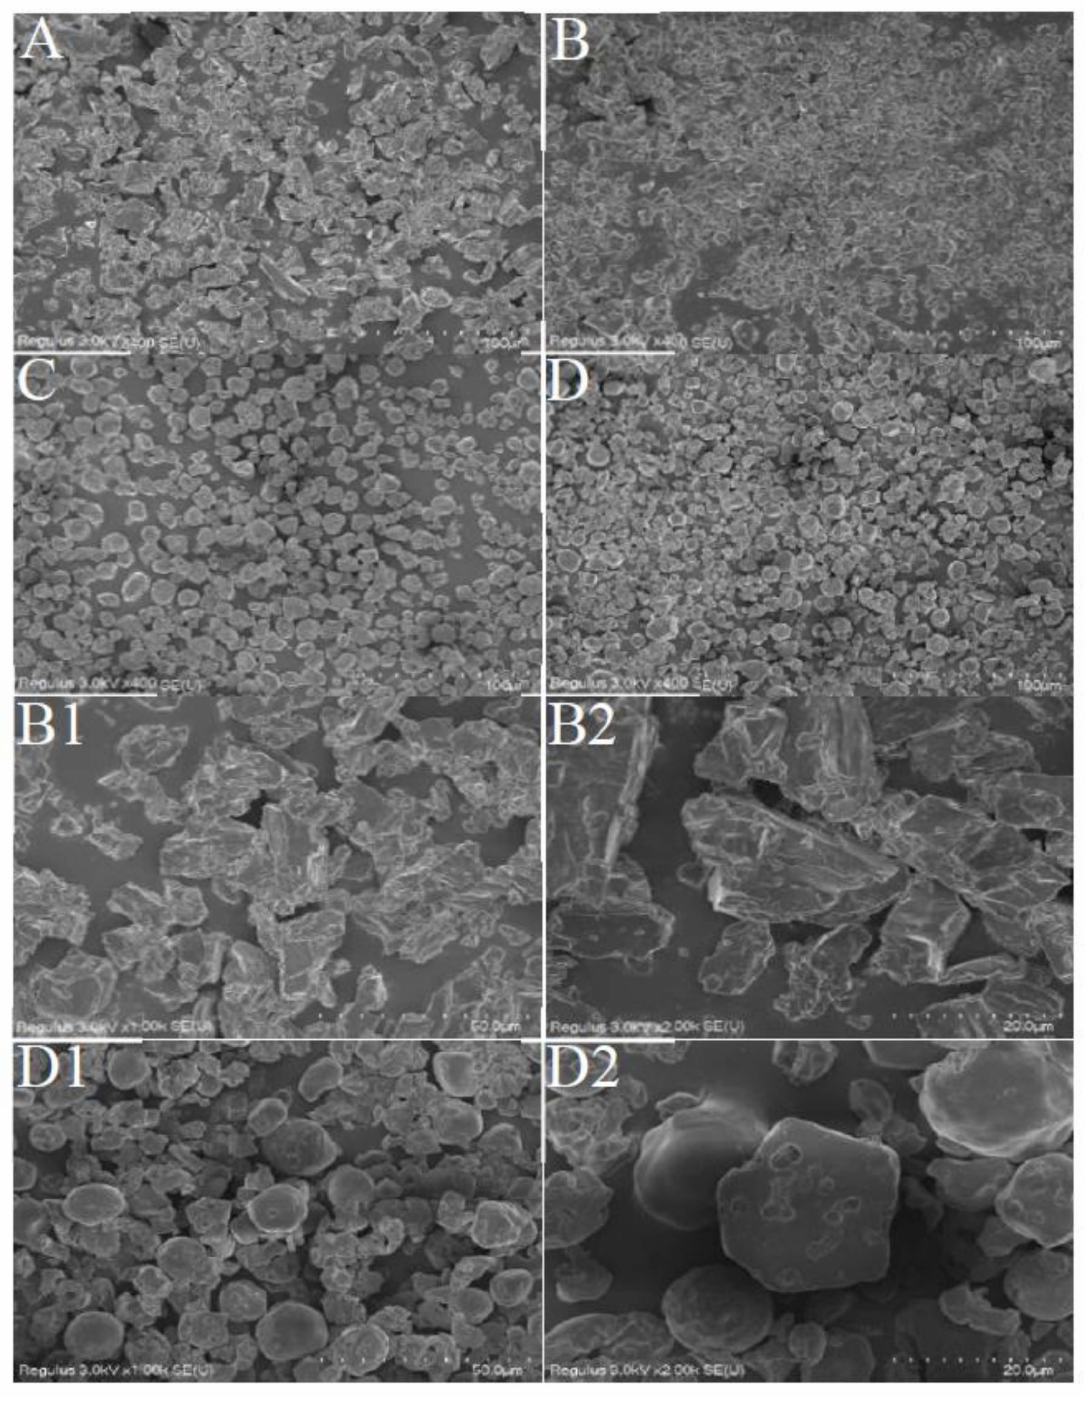
Figure 1. SEM of β -CD, PS and their CHO microcapsules. ( A ), β -CD (400-fold); ( B ), β -CDCHOM (400-fold); ( B1 ), β -CDCHOM (1000-fold); ( B2 ), β -CDCHOM (2000-fold); ( C ), PS (400-fold); ( D ), PSCHOM (400-fold); ( D1 ), PSCHOM (1000-fold); ( D2 ), PSCHOM (2000-fold). β -CD, β -Cyclodextrin; PS, Porous starch; CHO, cold-pressed hickory oil; β -CDCHOM, β -cyclodextrin cold-pressed hickory oil microcapsule; PSCHOM, Porous starch cold-pressed hickory oil